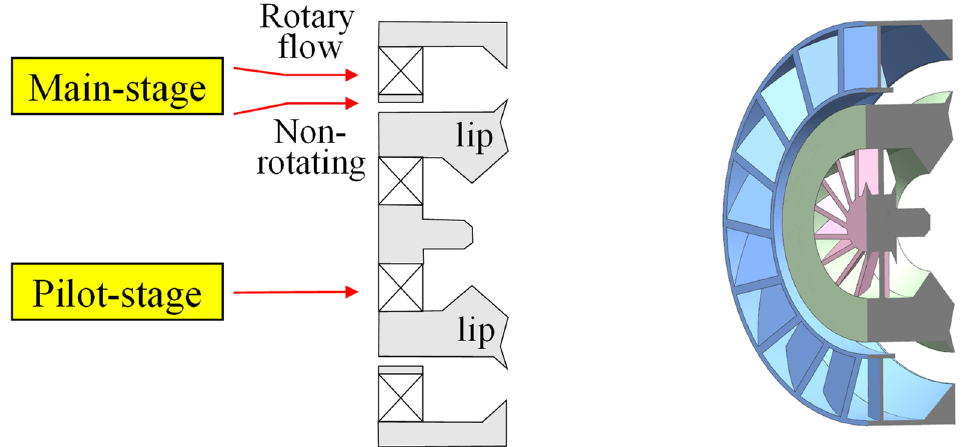
Figure 1. The swirler structure of the centrally staged high ‐ temperature ‐ rise combustor.